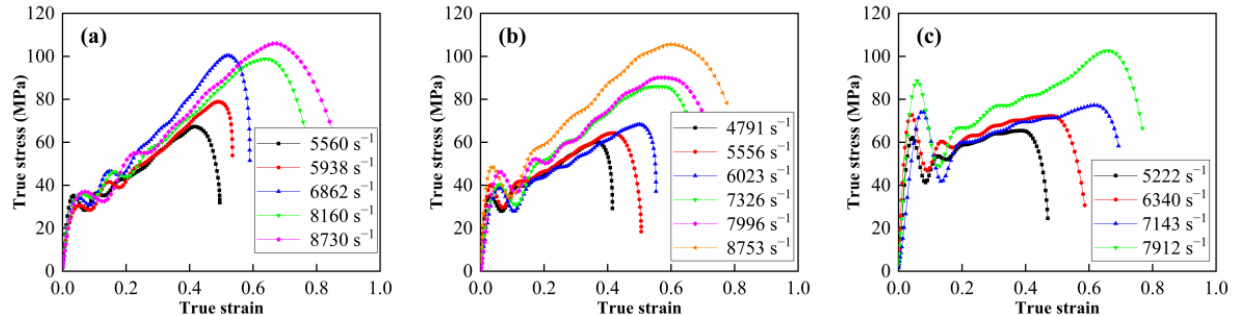
Figure 10. Strain to fracture versus the stress triaxiality.